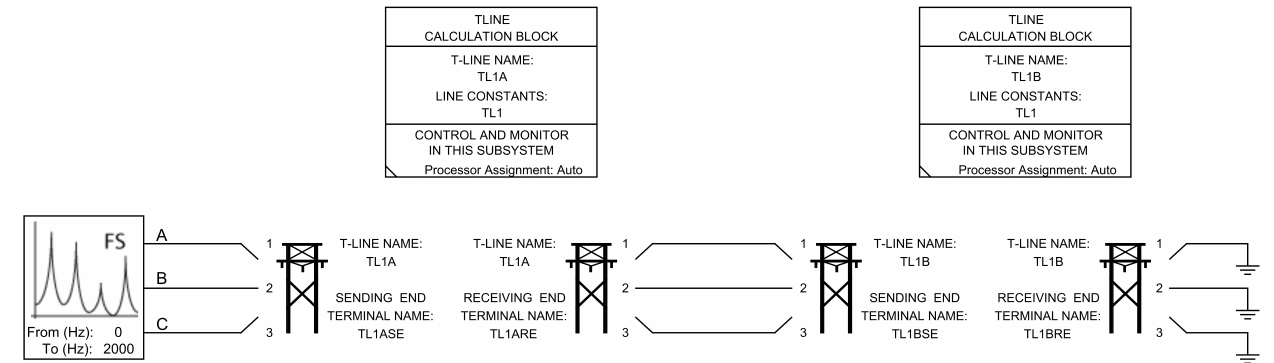
Figure 2. RTDS circuit Line Diagram of FRA measurements.